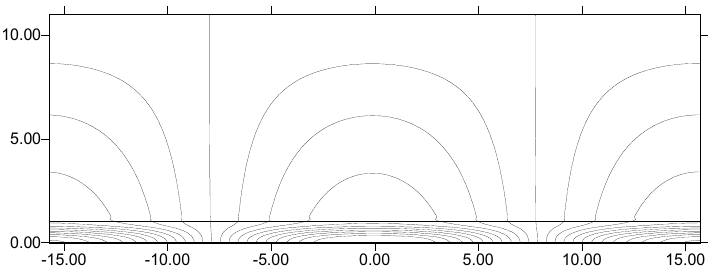
Figure 4. Streamlines of the longwave regime (only the upper part of the physical domain is shown).